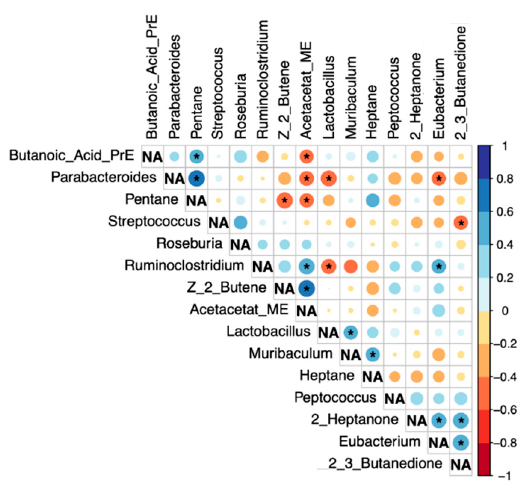
Figure 5. Correlation analysis (Spearman-Rho). Significant correlations ( p < 0.05) are marked with *. NA…not applicable.